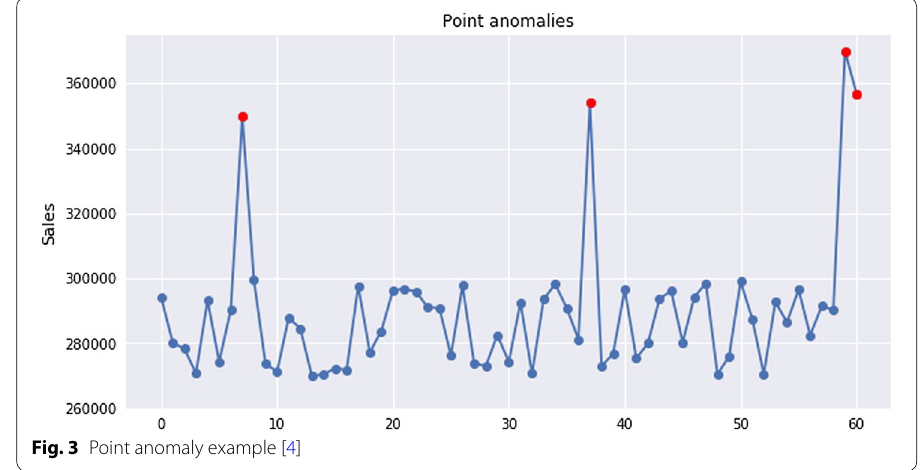
Fig. 3 Point anomaly example [4]